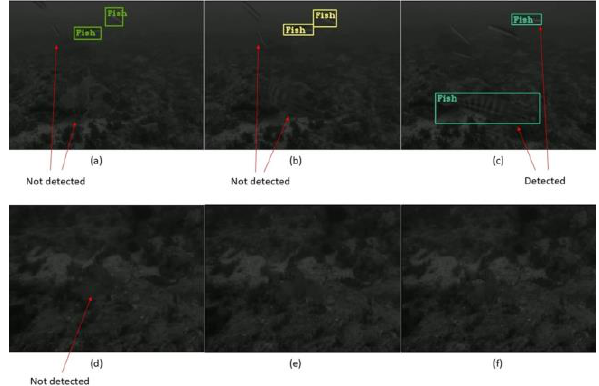
Figure 11 . Detection results for video frames in greyscale and low brightness: (a) Frame 532, (b) Frame 542, (c) Frame 563, (d) Frame 639, (e) Frame 650, and (f) Frame 657.